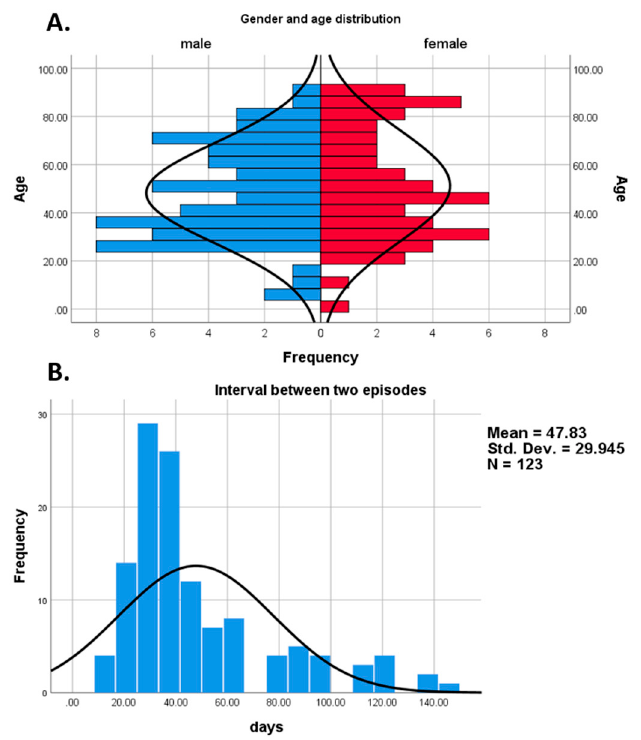
Figure 2. Age distribution of patients with repeatedly SARS-CoV-2 positivity ( A ), and the histogram of repeated positivity lengths ( B )